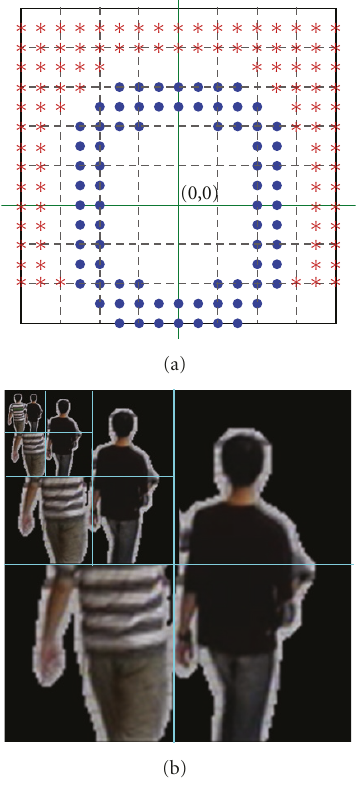
Figure 4: (a) The ellipse head model. (b) The pyramid down sampling